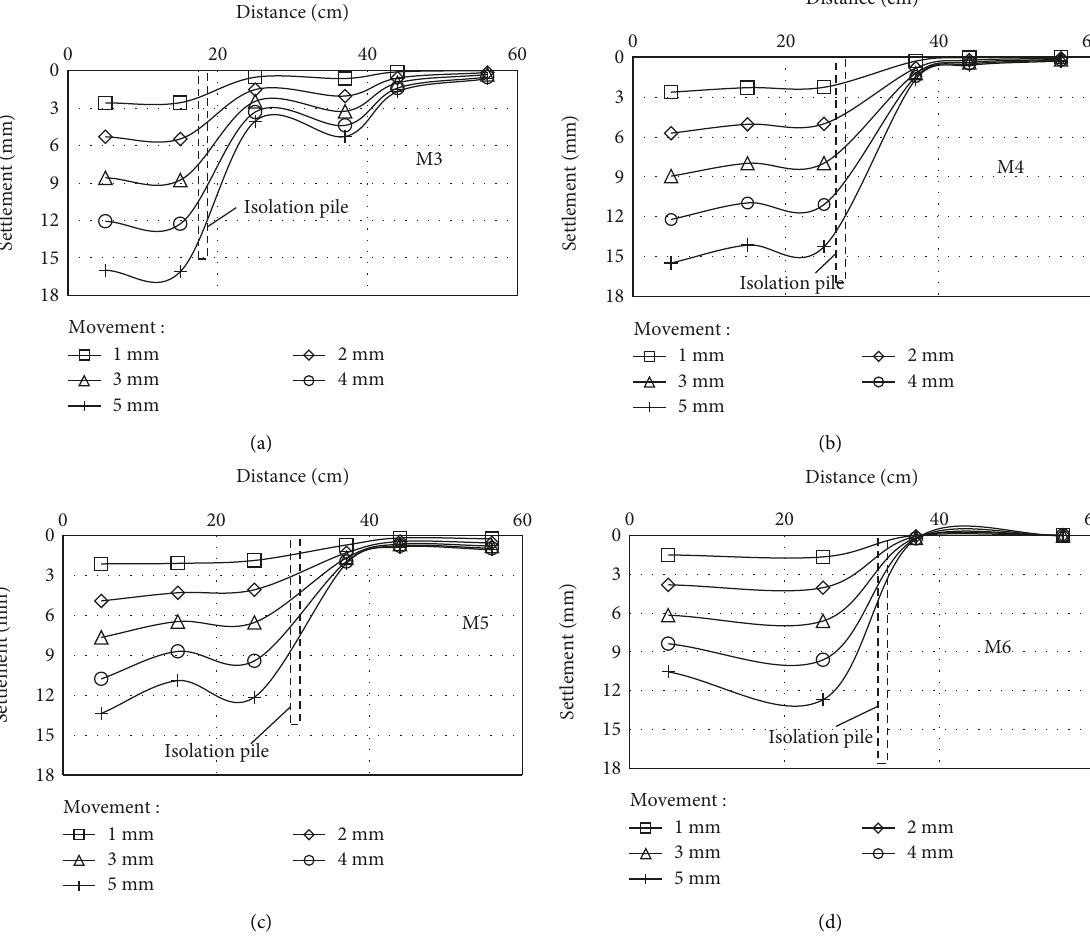
Figure 11: LVDTs measured displacement of the soil surface in the samples (a) M3, (b) M4, (c) M5, and (d)